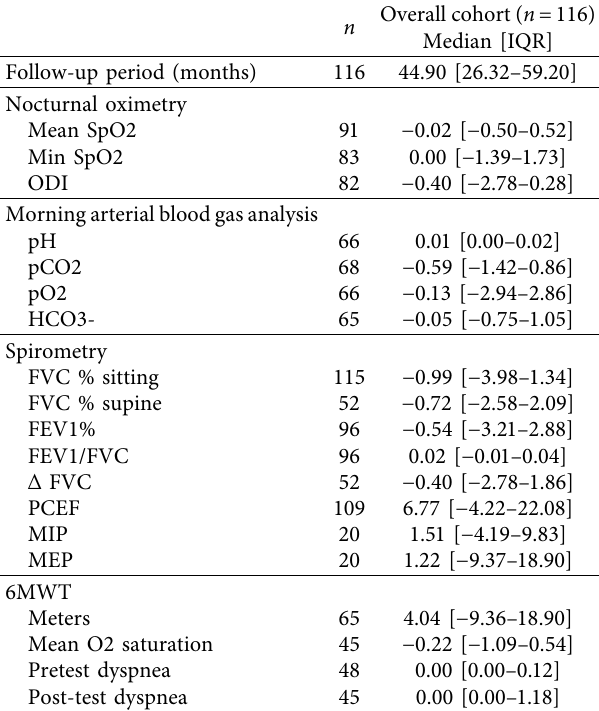
Table 5: Changes per year of respiratory features from the cohort available for